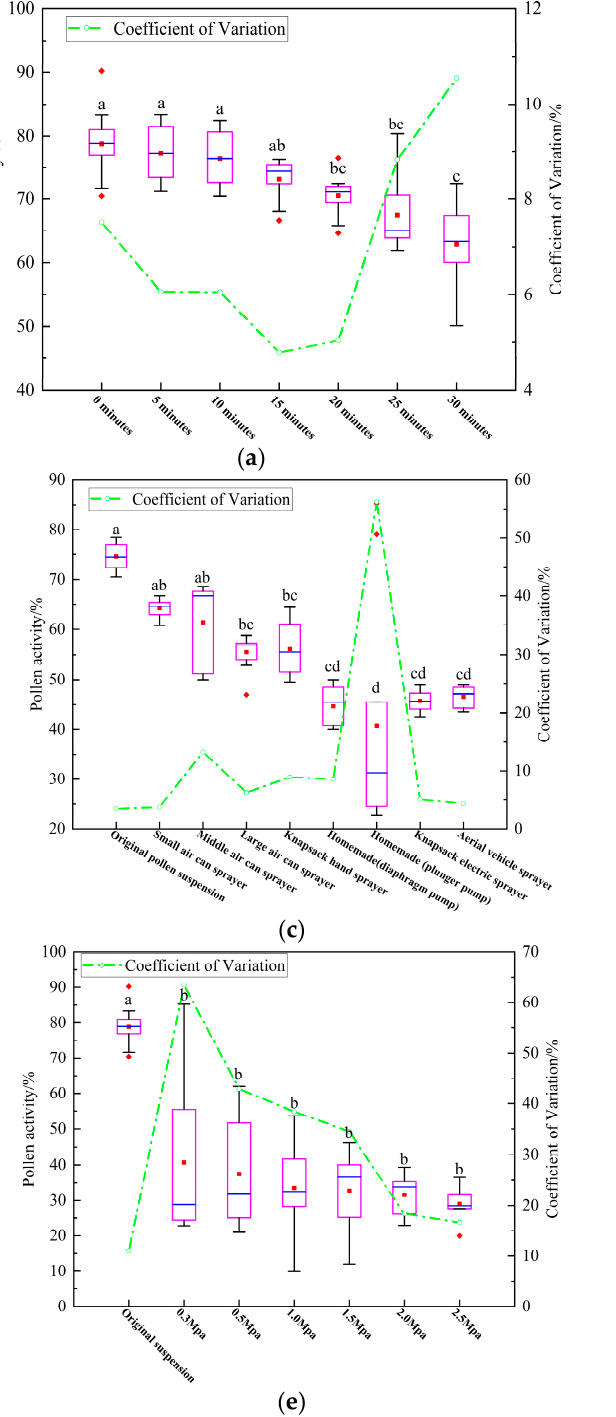
Figure 5. Results of the influence of pollen suspension storage time and sprayer parameters on pollen activity. ( a ) Pollen suspension storage time, ( b ) recirculation device, ( c ) different sprayers (pumps), ( d ) nozzle sizes, ( e ) spraying pressures and ( f ) rpm of RA. Different letters in ( b ) indicated different sampling positions (Figure 2). Different letters indicate significant differences (Duncan test, α = 0.05).